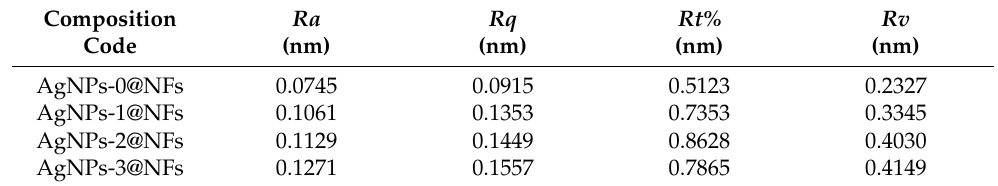
Figure 5. Roughness of ( a ) AgNPs-0@NFs, ( b ) AgNPs-1@NFs, ( c ) AgNPs-2@NFs and ( d ) AgNPs-3@NFs. Table 2. Summary of the roughness parameters ( R a ): average roughness ( R q ): root mean square roughness ( R t ): maximum roughness’s height ( R v ): maximum roughness valley depth ( R p ): maximum roughness peak height ( R tm ): average maximum height of the roughness.